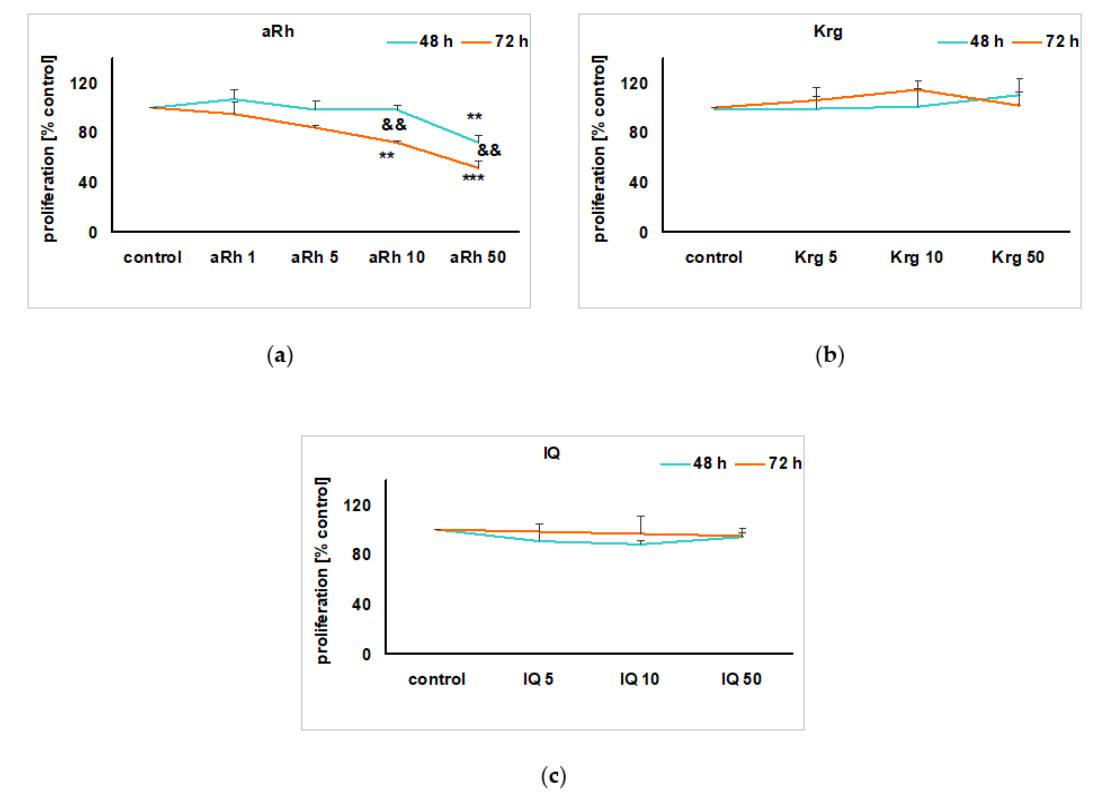
Figure 2. The impact of the tested flavonols on SH-SY5Y cells proliferation: ( a ) α-rhamnoisorobin (aRh); ( b ) kaempferitrin (Krg); ( c ) isoquercitrin (IQ). The cells were seeded at density of 1 × 10 4 cells/well, in 96-well plates in DMEM containing 10% FBS, and after 24 h were treated either with vehicles or with aRh (1–50 µM), Krg (5–50 µM) and IQ (5–50 µM) for the next 48 and 72 h. Data from MTT reduction assay were normalized to the vehicle-treated cells for the particular time point and are presented as the mean ± SEM from two independent experiments with three repetitions. Two-way ANOVA were used for statistical analysis, ** p < 0.01 and *** p < 0.001 vs. vehicle treated cells, && p < 0.01 72 h vs. 48 h.